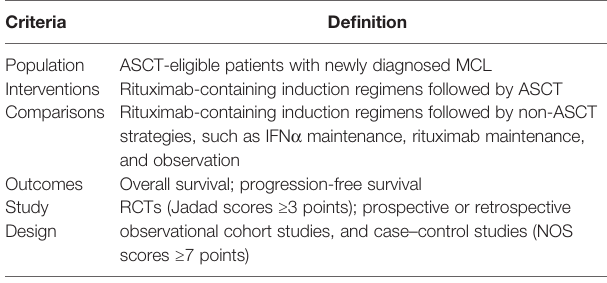
TABLE 1 | Population, interventions, comparisons, outcomes, and study design (PICOS) criteria for study. Criteria De fi nition Population